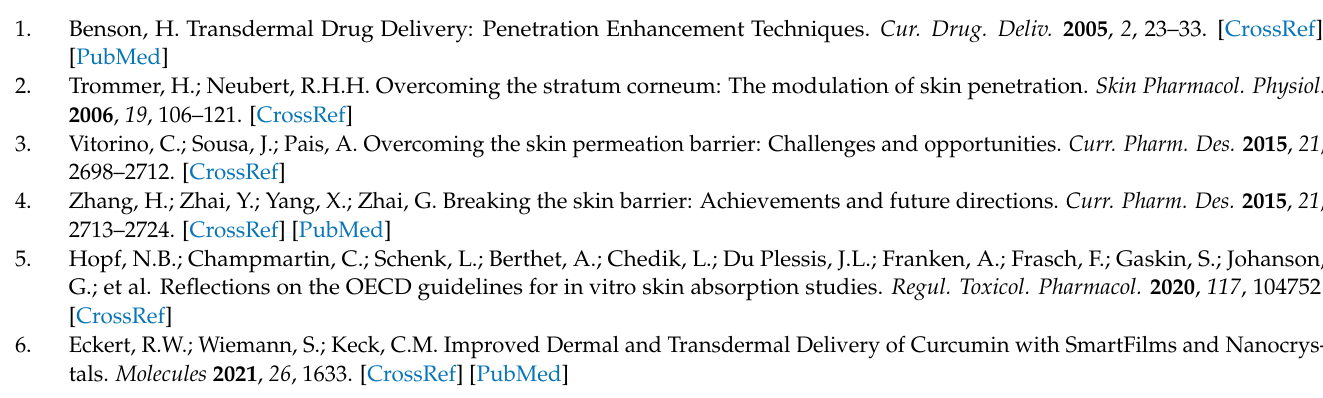
Figure S2: Scheme for the assessment of the different penetration data. Explanation cf.